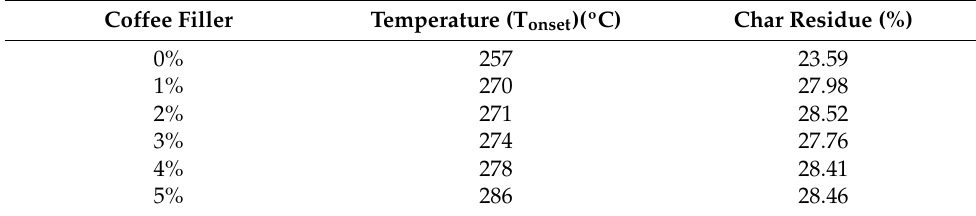
Table 1. Major thermal decomposition step of seaweed/coffee biopolymer